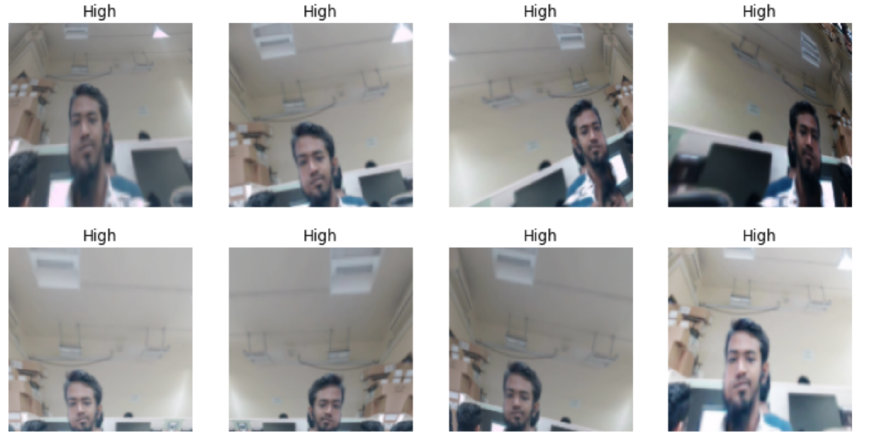
Figure 3. Image data augmentation examples.